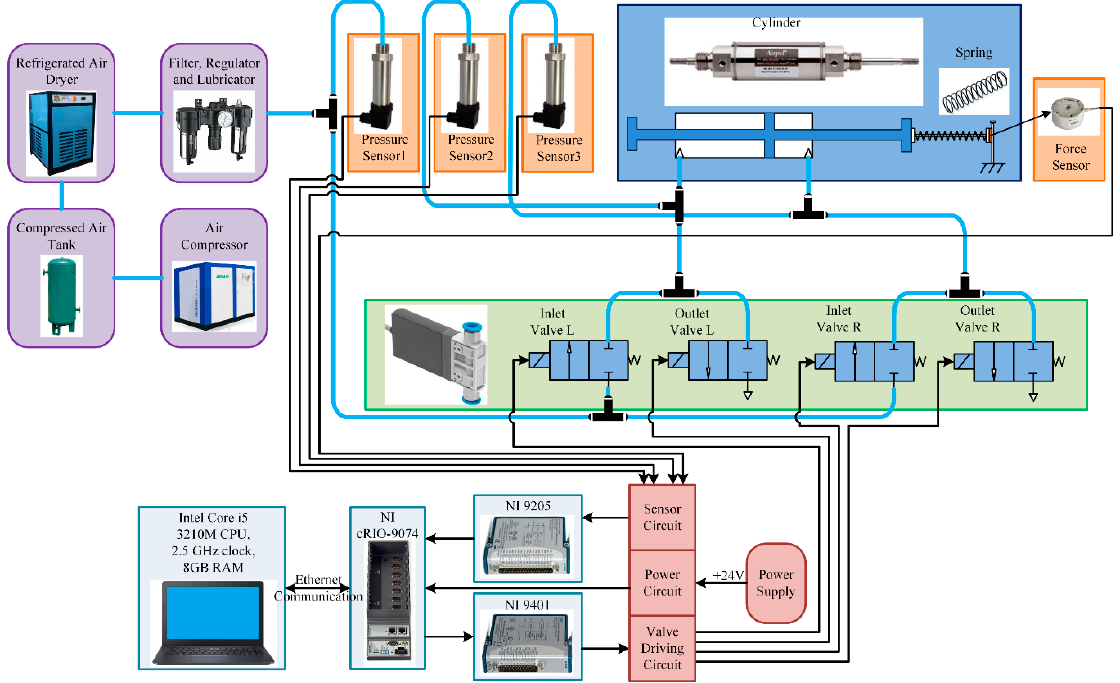
Figure 14. Final experimental setup.